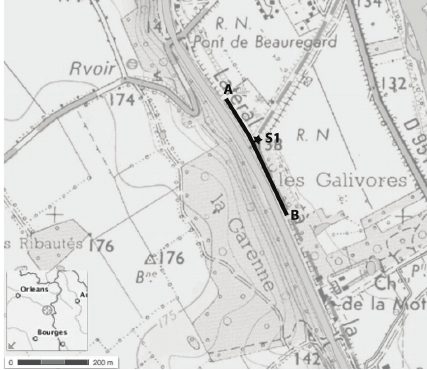
Figure 2: Location of the study zone and the S1 coring.